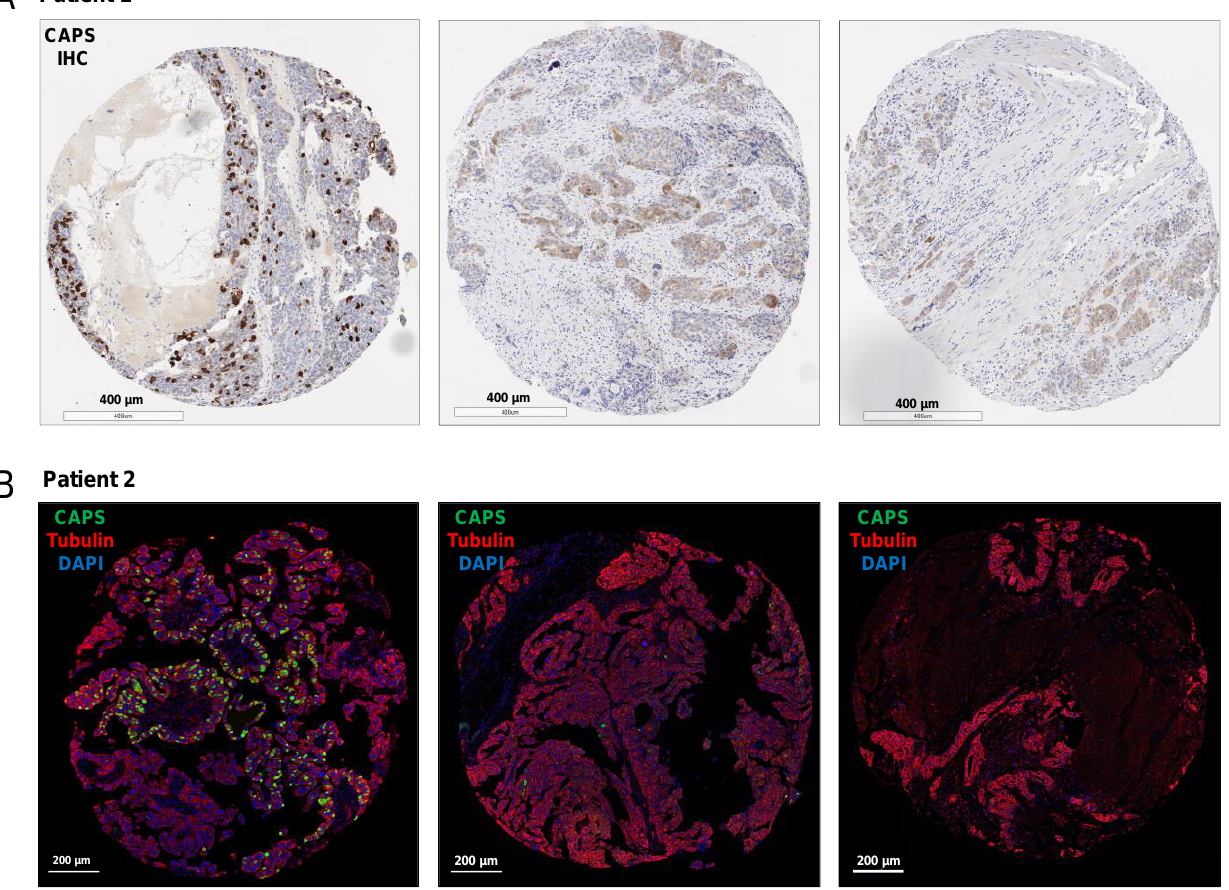
Figure 5. Detection of CAPS+ cells in primary, synchronous metastatic, and metachronous/recurrent metastatic HGSOC. Shown are two examples of HGSOC in which primary tumors exhibited high expression of CAPS by ( A ) IHC and ( B ) mIF.